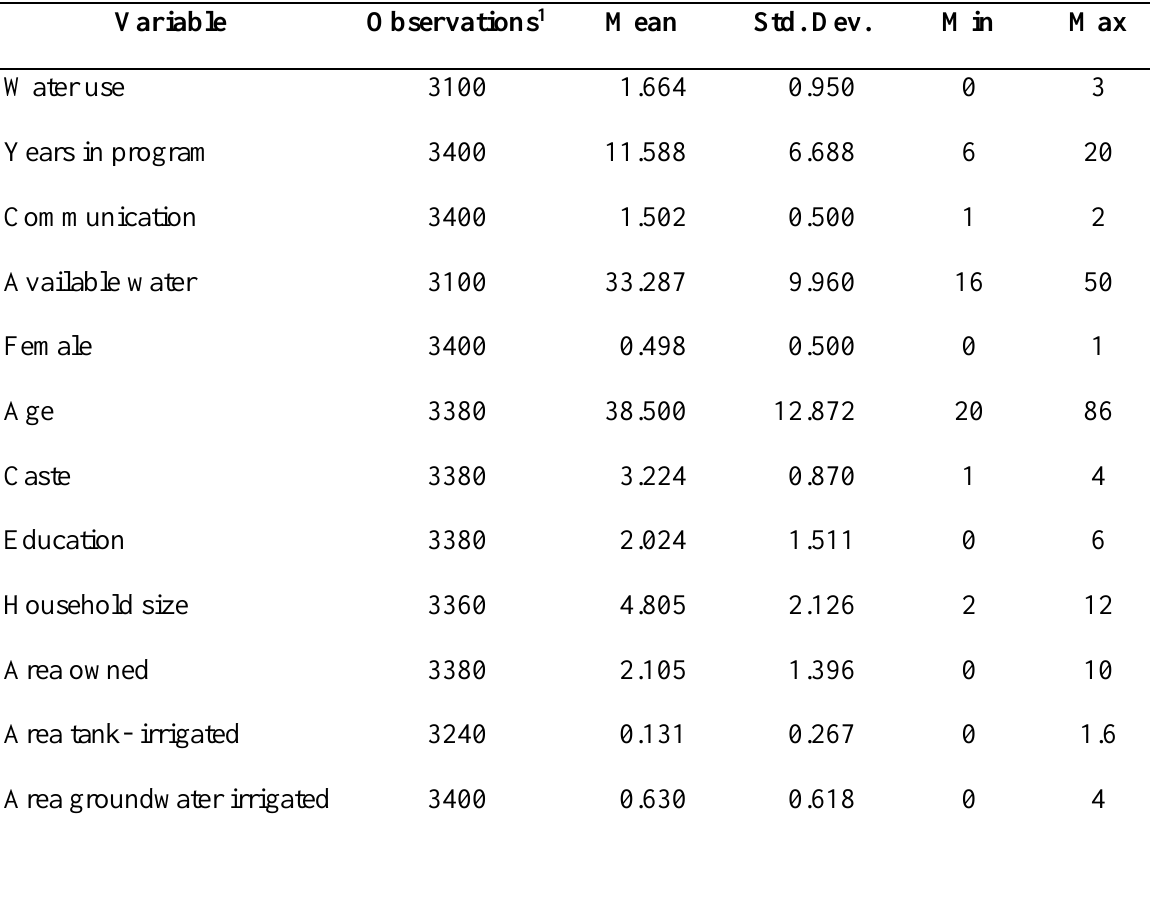
Table A2.2 Summary